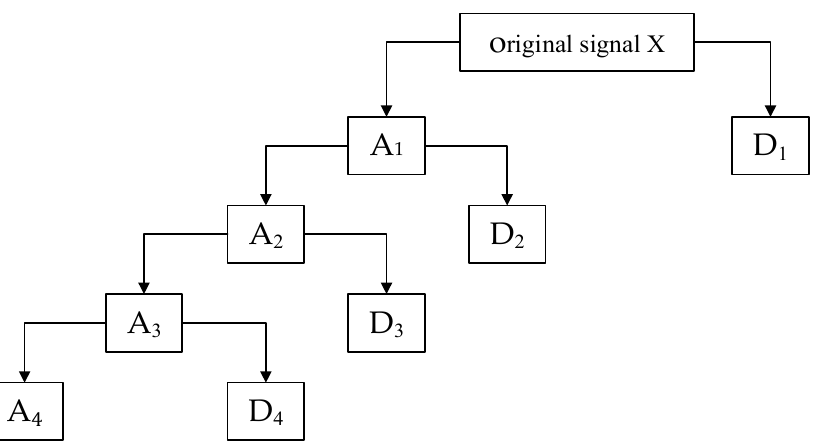
Figure 2. DWT decomposition schematic. A i indicates the i th layer approximate signal and D i represents the i th layer detailed signals.